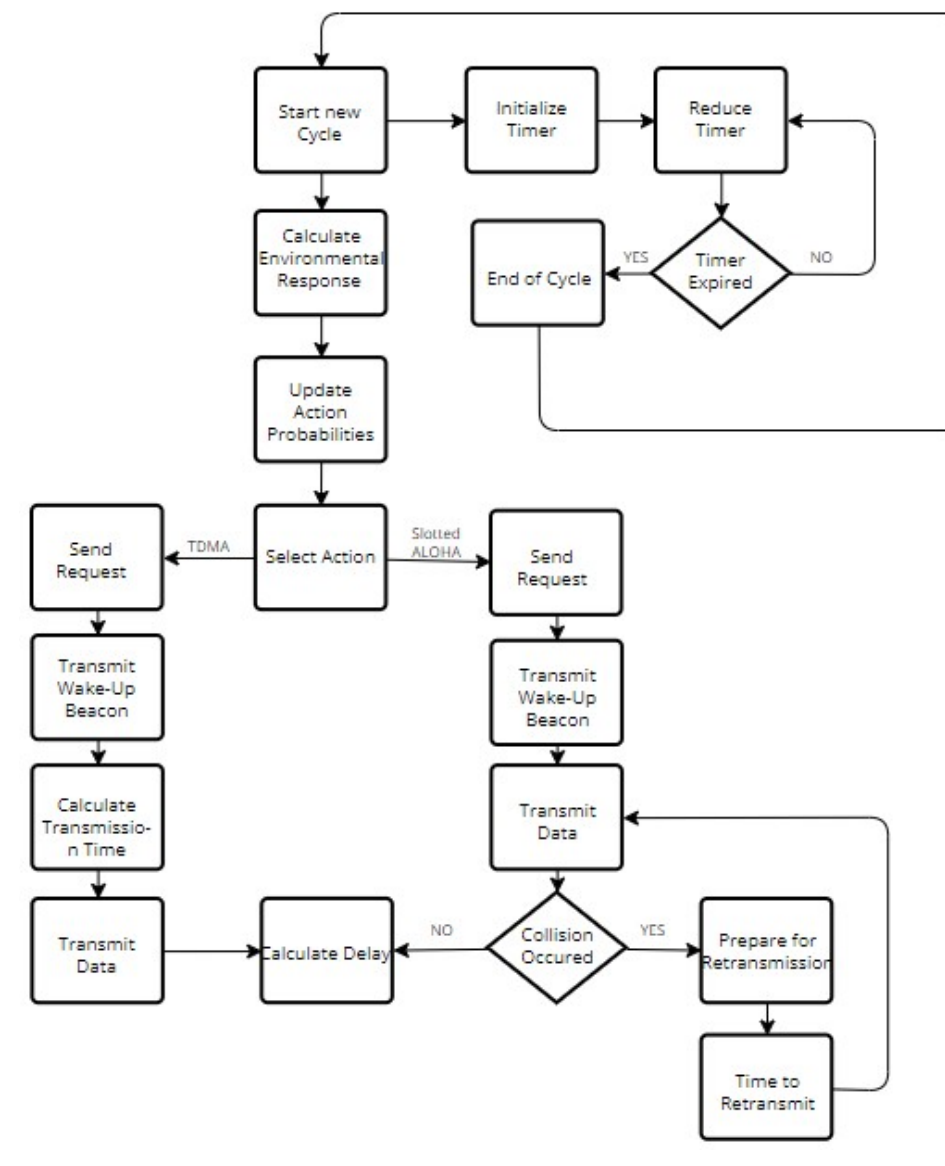
Figure 4. Algorithm flow chart.